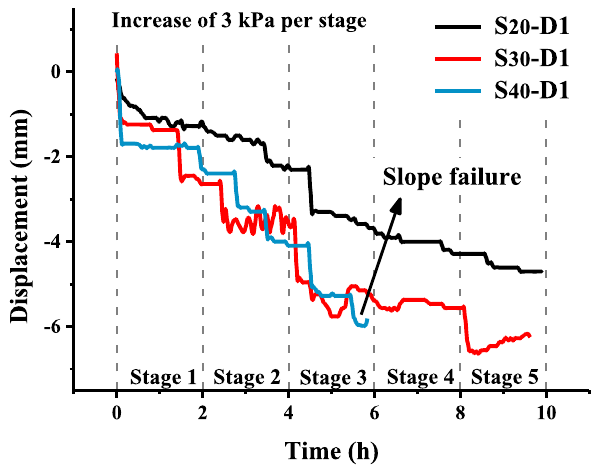
Figure 13. Displacement of the slope after freeze–thaw